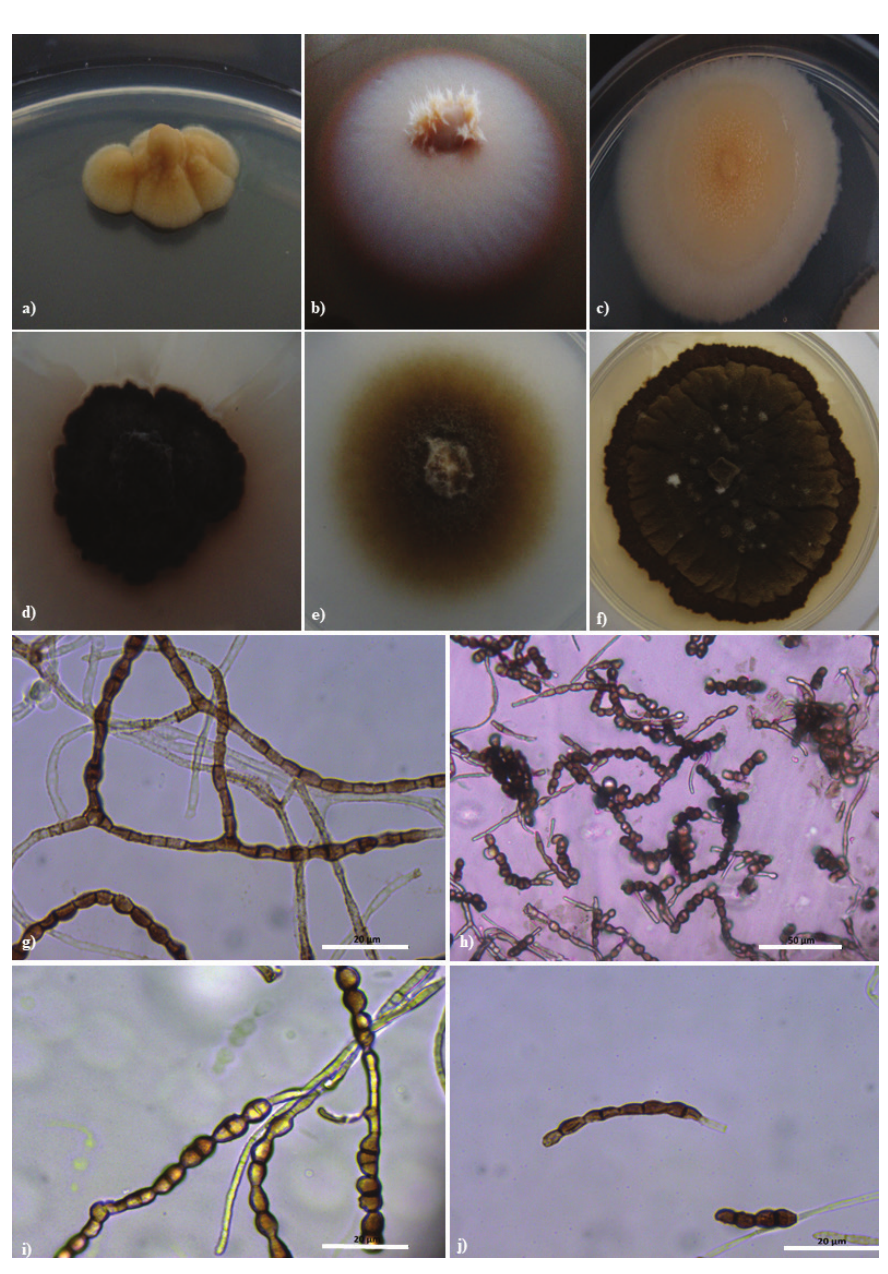
Figure 2. Aeminium ludgeri a Colony appearance on PDA b Colony appearance on MEA+10% NaCl (w/v) c Colony appearance on DG-18 d Colony appearance on PDA after maturation e Colony appear- ance on MEA+10% NaCl (w/v) after maturation f Colony appearance on DG-18 after maturation g Ini- tial simple, branched, septate hyphae becoming toruloid-like (scale 20 µm) h Differentiated, toruloid-like hyphae and mature chains of arthroconidia (scale 50 µm) i Intercalary and terminal conidial chains (scale 20 µm); j typical aspect of arthroconidia (scale 20